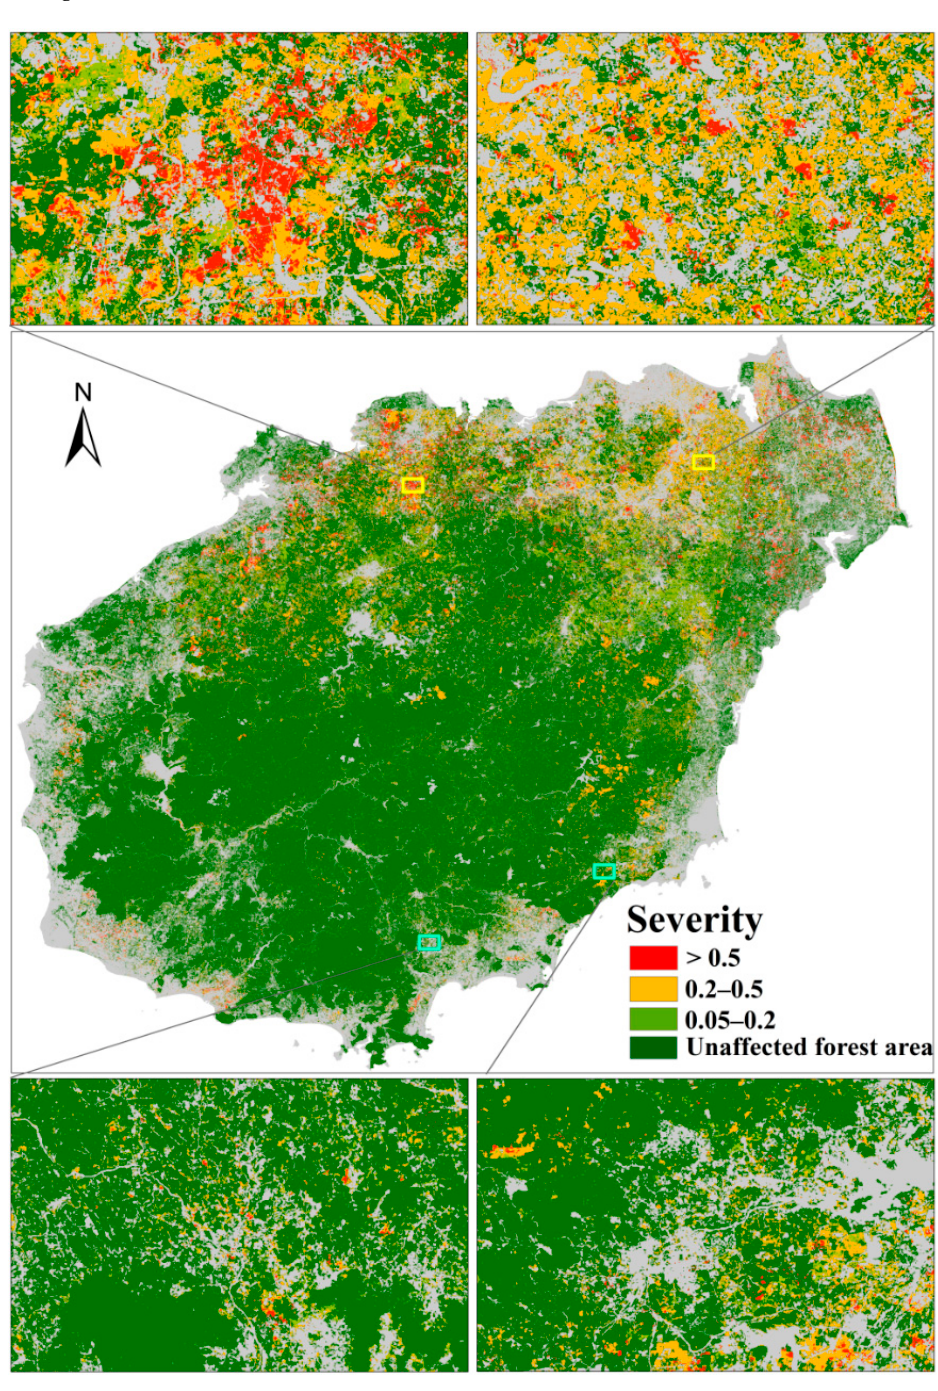
Figure 8. The spatial distribution of affected area and damage severity (0–1) caused by Typhoon Rammasun in Hainan